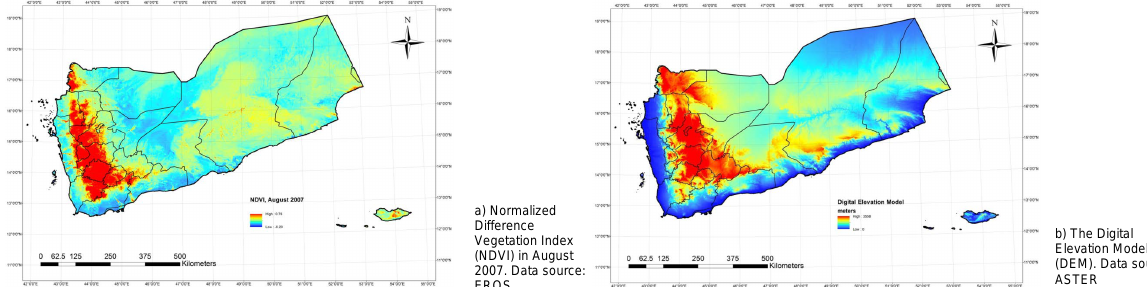
Fig. 4. Vegetation index and digital elevation